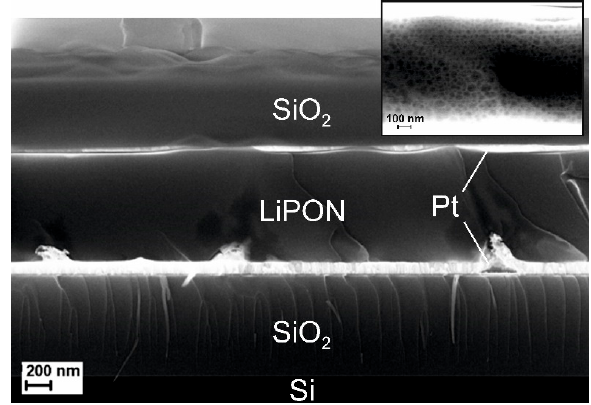
Figure 4. The cleavage of a Pt(100 nm)/LiPON(1 µm)/Pt(100 nm) cell (microscope Zeiss Supra 40). The inset shows a section of LiPON cleavage. The apparent porosity of LiPON in the inset is partly due to the microscopic products of lithium reaction, with atmospheric vapors and gases shown as dark spots.